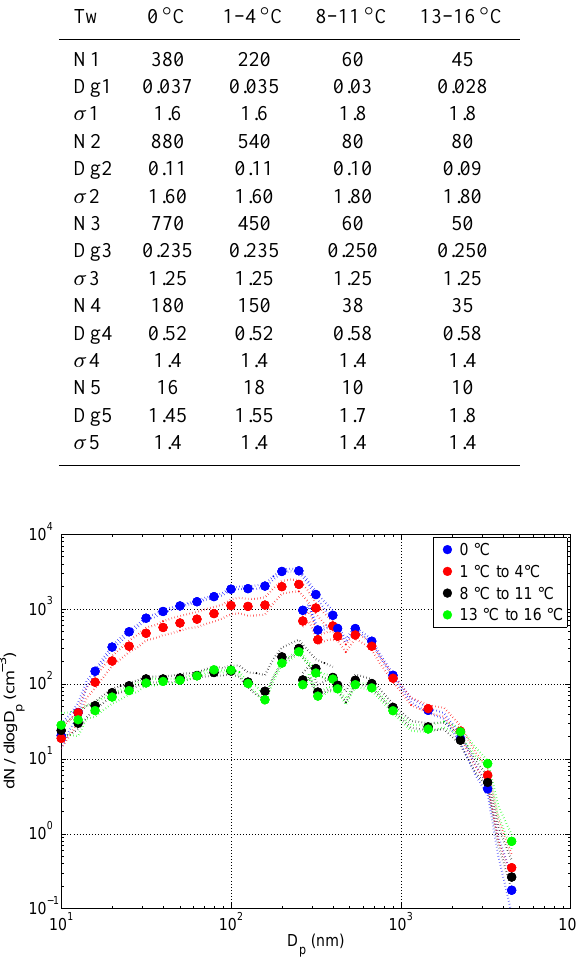
Fig. 5. Particle number size distributions from 35gkg − 1 NaCl wa- ter for different water temperature ranges. Median size distributions were calculated for temperatures at 0 ◦ C (RH mean = 29%), between 1 ◦ C and 4 ◦ C (RH mean = 29%), between 8 ◦ C and 11 ◦ C (RH mean = 30%) and between 13 ◦ C and 16 ◦ C (RH mean = 21%). Dotted lines represent the 25th and 75th percentiles. Only every second data point is shown for clarity.